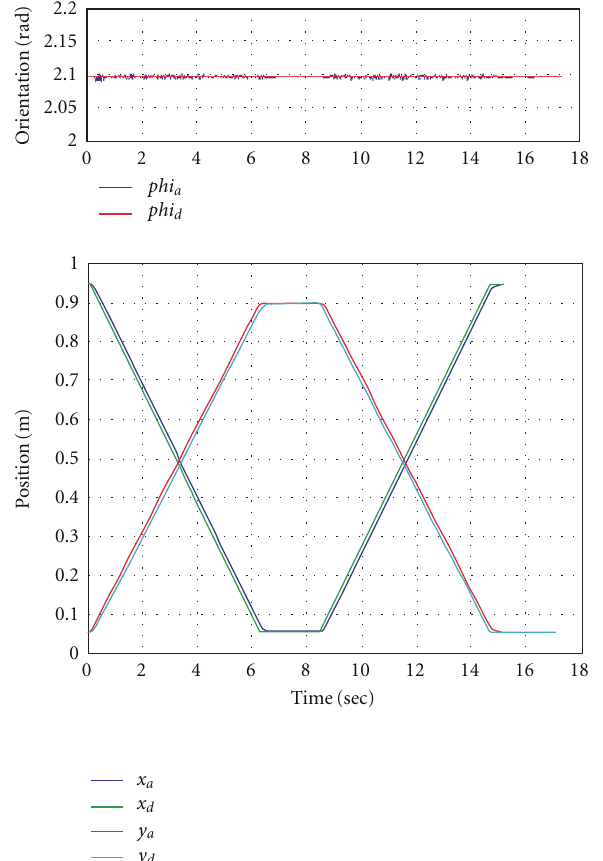
Figure 4: Robot motion test.